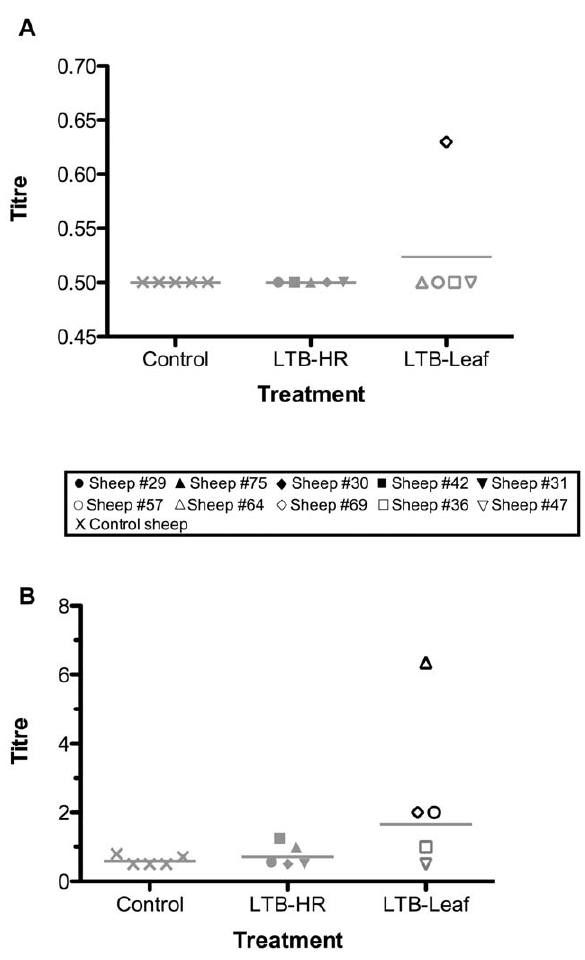
Figure 3. LTB-specific IgG (A) and IgA (B) antibody titres in abomasum mucus following oral immunisation with four doses of control or LTB-transgenic plant materials. The horizontal lines represent geometric means. Black symbols denote positive responders defined as sheep with antibody titres at least three standard deviations above the control mean, non-responders are indicated by grey